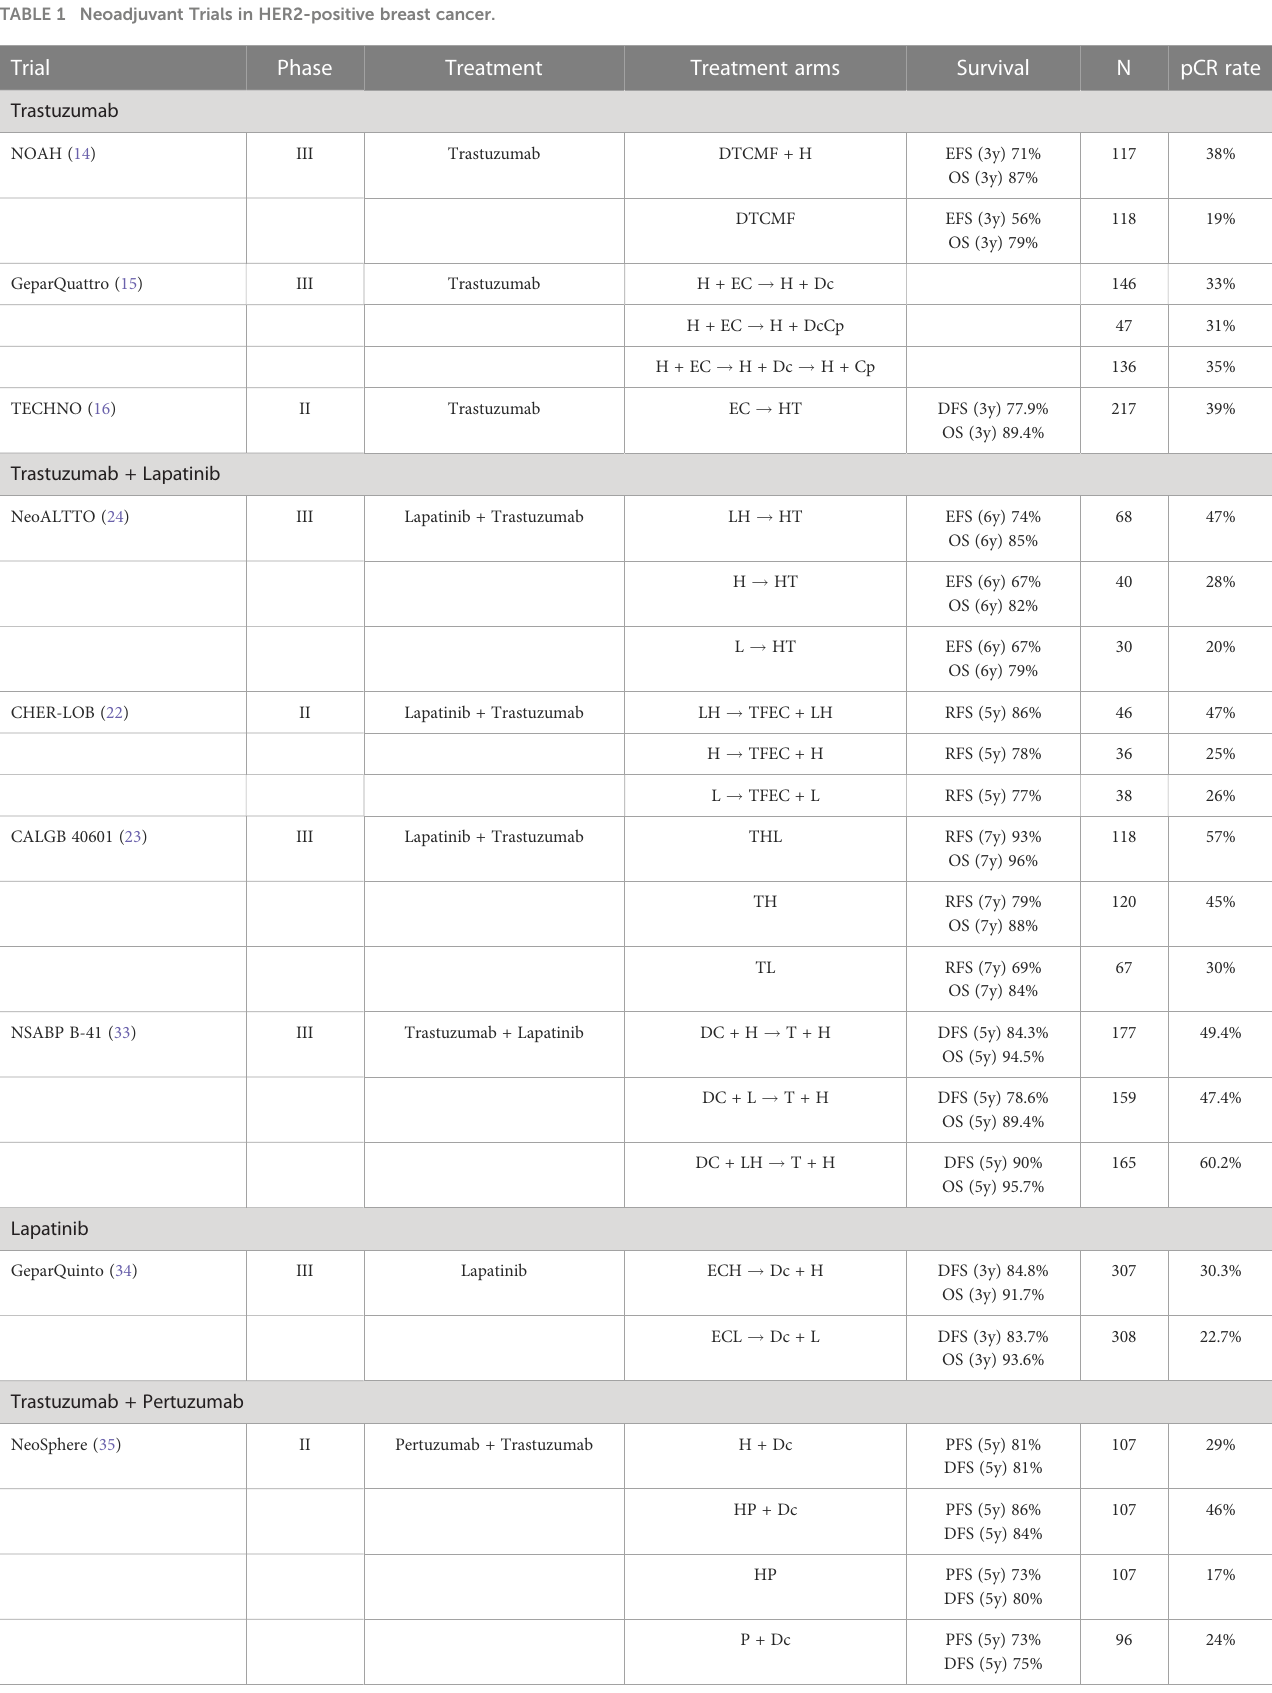
TABLE 1 Neoadjuvant Trials in HER2-positive breast